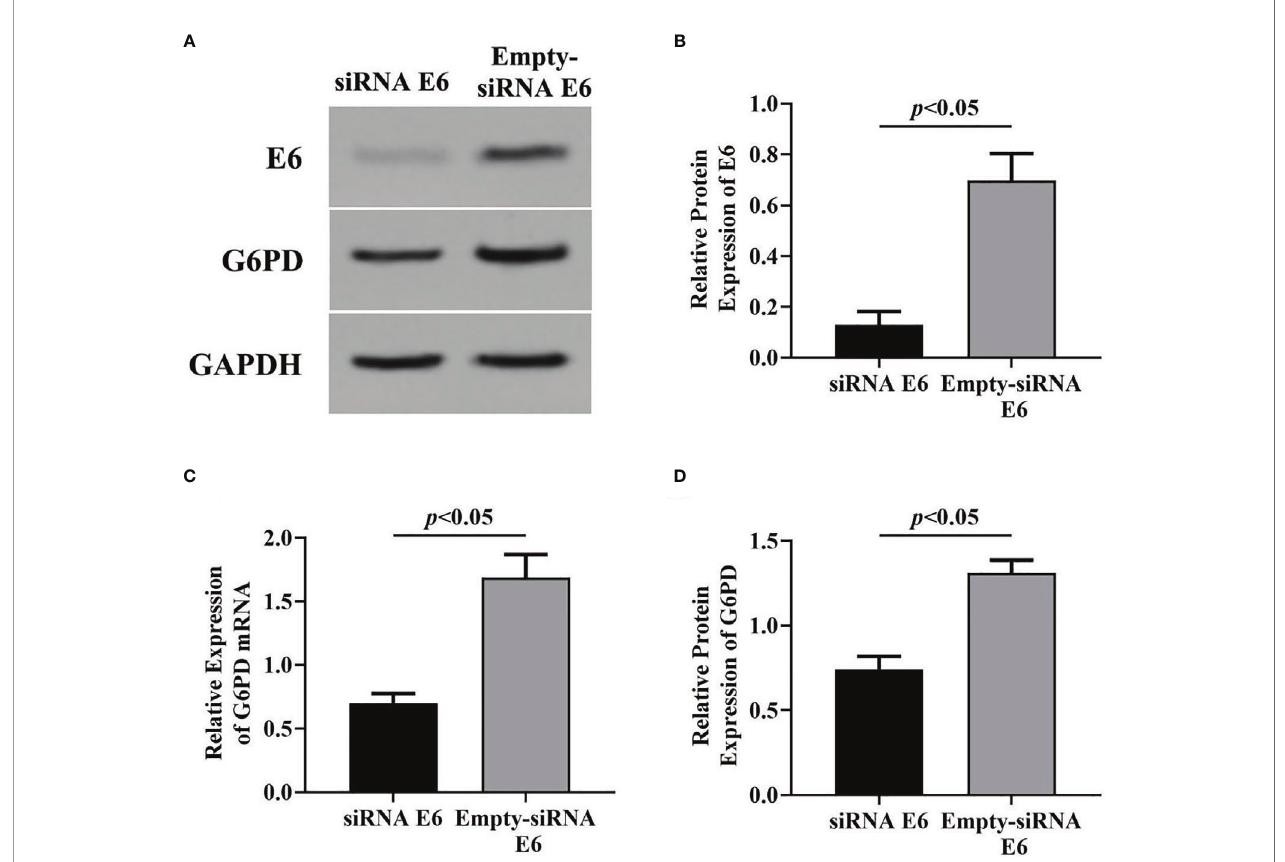
FIGURE 3 | Effects of inhibition of HPV16 E6 expression on G6PD expression. After stable expression of pcDNA HPV16 E6 plasmid in HeLa cells, siRNA E6 was employed to interfere its expression. Then, the relative expression of E6 protein and G6PD mRNA/protein was detected. The expression levels of E6 protein (A, B) and G6PD mRNA/protein (A, C, D) were also indicated by Western blots or RT-qPCR. (A) Representative blots from two groups. Statistical plots of the relative expression of E6 protein (B) , and G6PD mRNA (C) and protein (D) . Data are presented as means ± SD ( n =